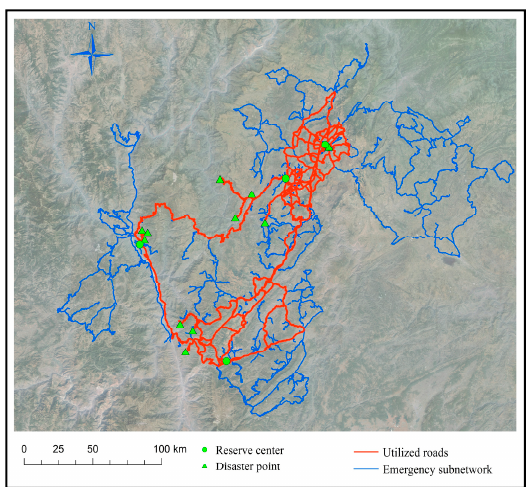
Figure 8. The emergency material dispatching result in the static situation: ( a ) single-objective; ( b ) multi-objective, where a positive value is the departure rate and a negative value is the arrival rate. Figure 9. The utilized road in the emergency network. Figure 9. The utilized road in the emergency network.